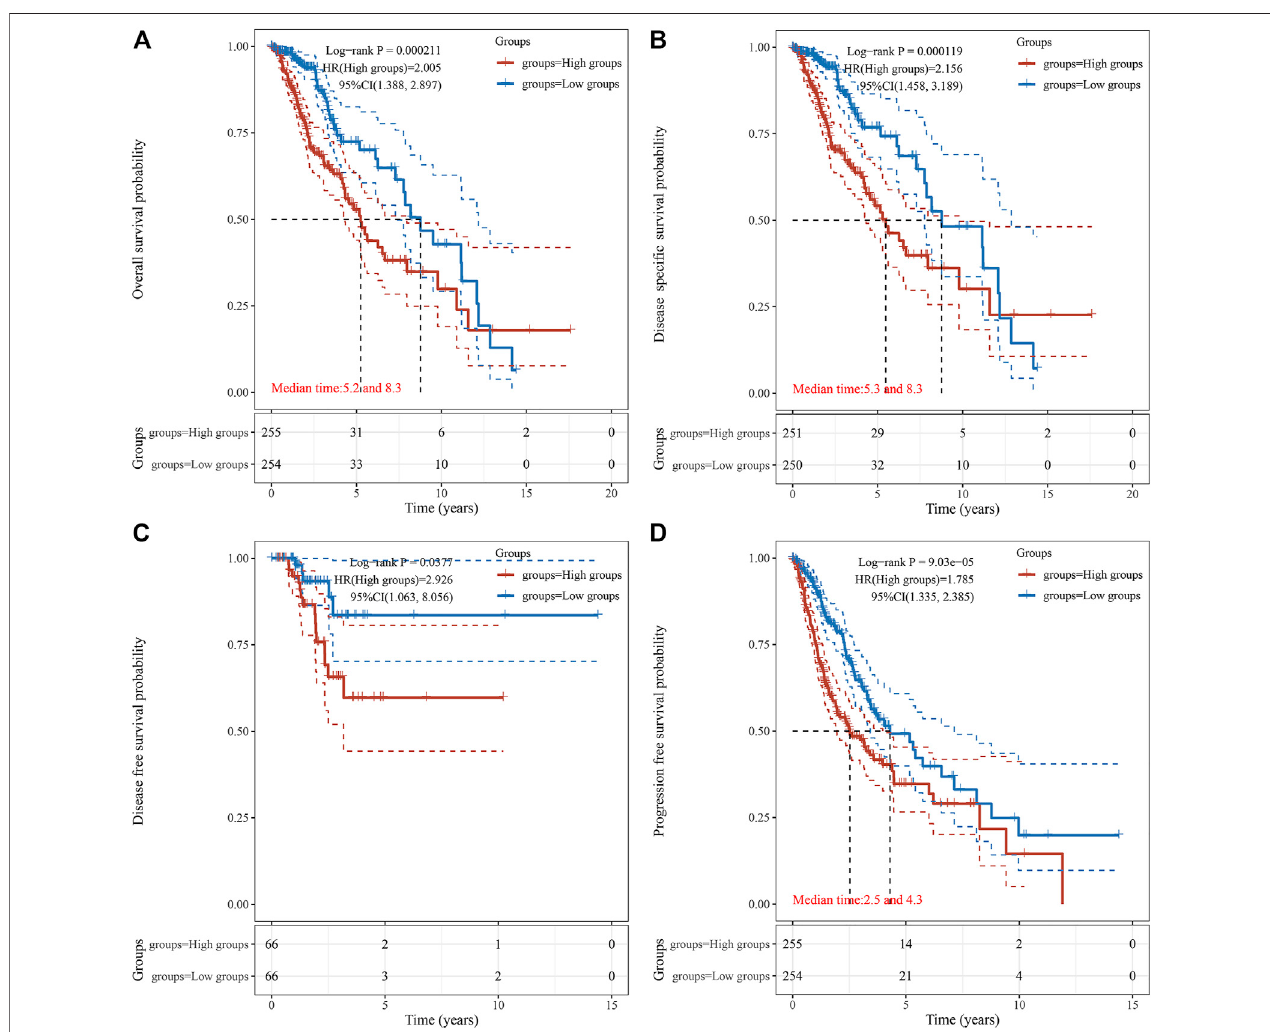
FIGURE3| The correlation between TUBA1Cexpression and OS (A) ,DSS (B) , DFS (C) , andPFS (D) .Thecorrelation ofTUBA1Cexpression withTMEand TIICs.